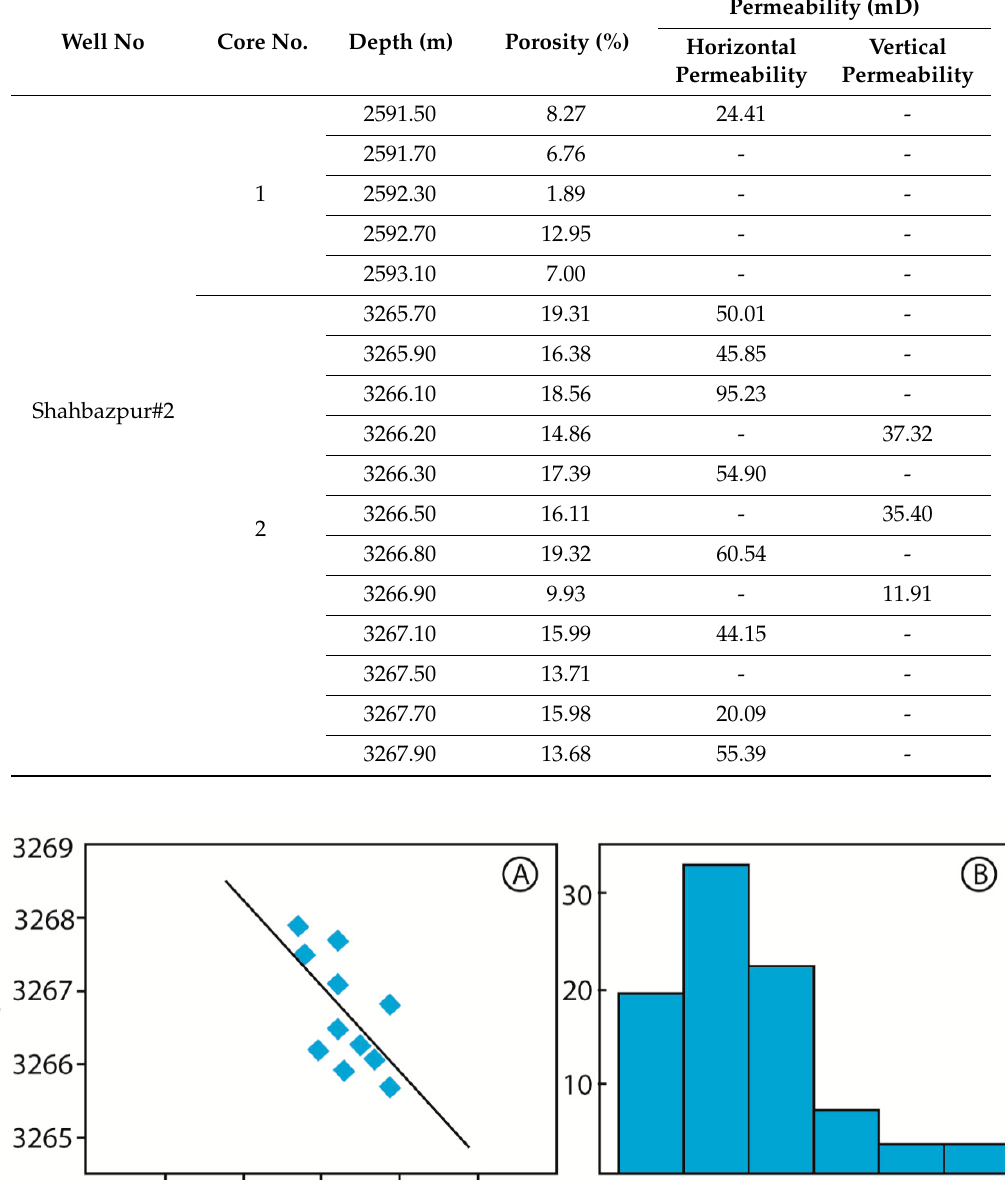
Table 3. Core petrophysical parameters of Shahbazpur#2 well at di ff erent depths.